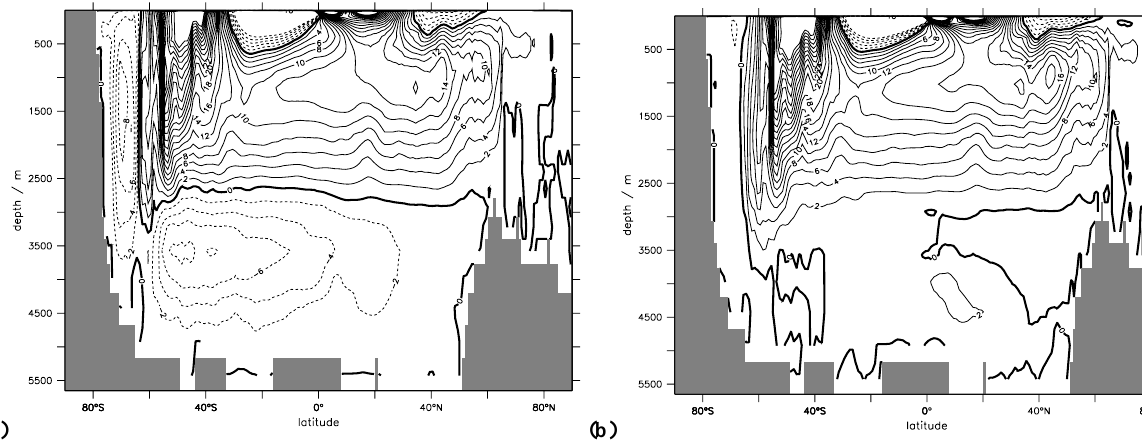
Fig. 15. As Fig. 14, but for the GMOC. Contour line interval is 2Sv.